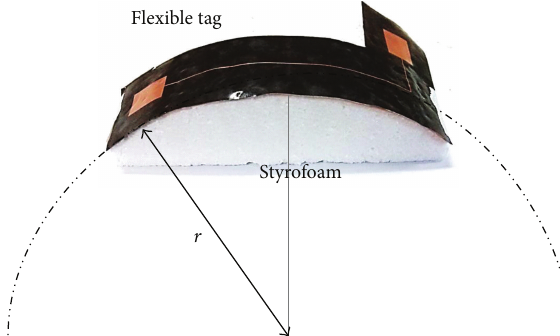
Figure 8: Photograph of the bent flexible tag mounted on a bending jig.